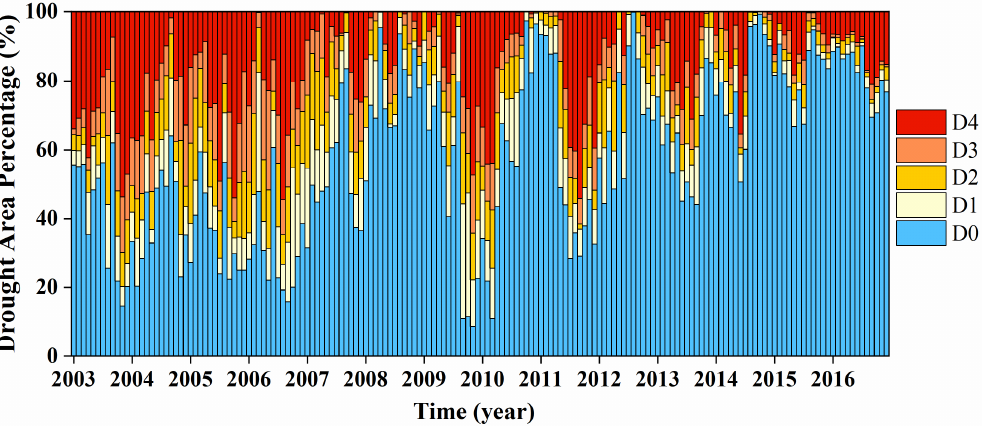
Figure 9. The area percentage of drought with different severity in Southwest China based on TSDI.